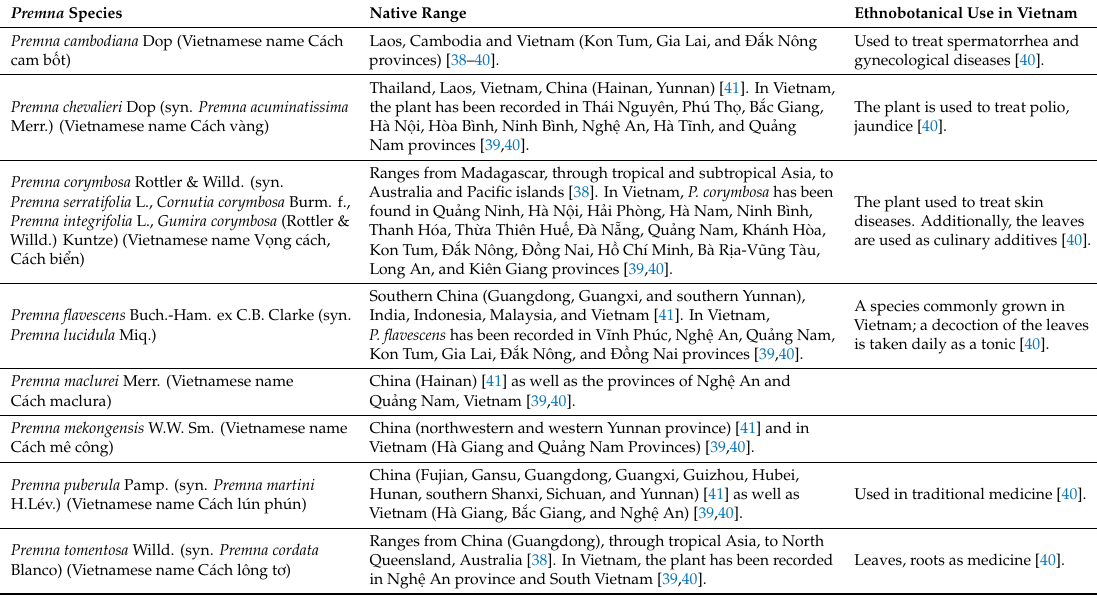
Table 1. Premna species examined in this